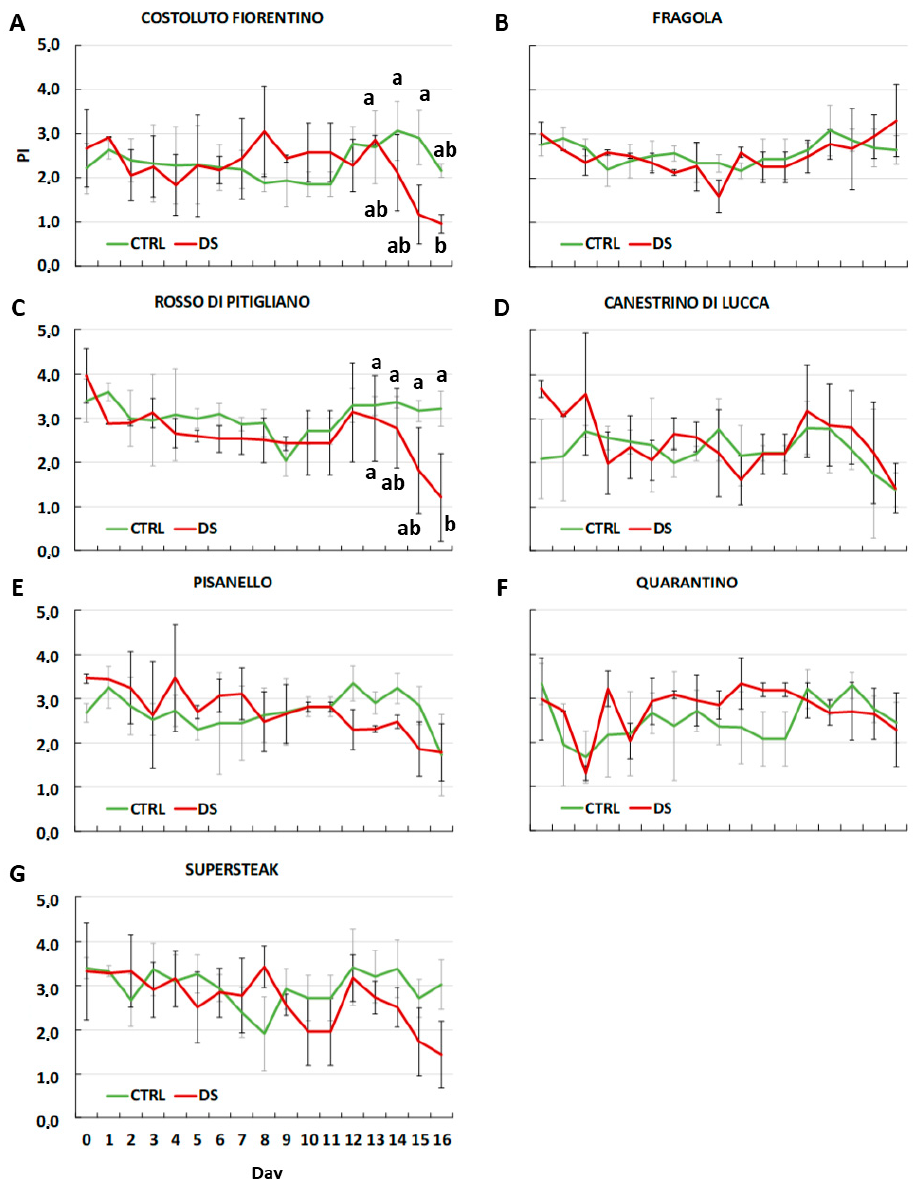
Figure 3. Performance index (PI ABS ) in six local varieties ( A – F ) and one commercial cultivar ‘Supersteak’ ( G ) of tomato ( Solanum lycopersicum L.) subjected to drought stress (no water for 16 days) relative to the controls (regularly well-watered plants). Two-way factorial ANOVA followed by Tukey post-hoc test was used to determine the statistical significance of differences. Points with the same lower-case letters do not differ significantly ( p > 0.05).